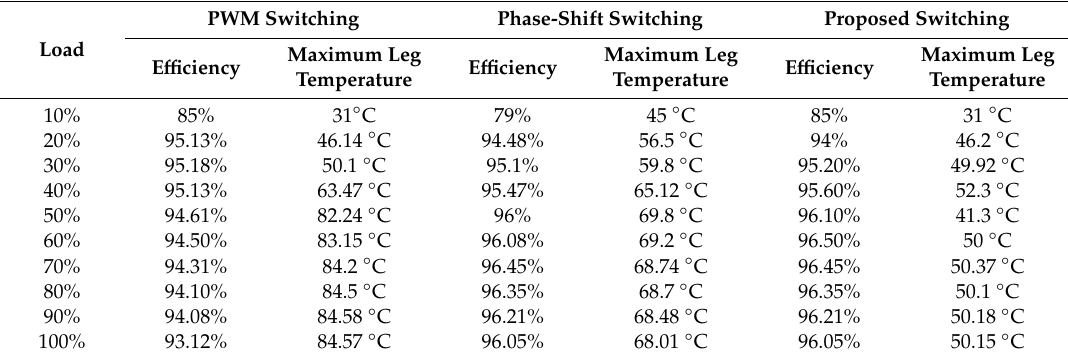
Table 3. E ffi ciency and maximum leg temperature for each switching